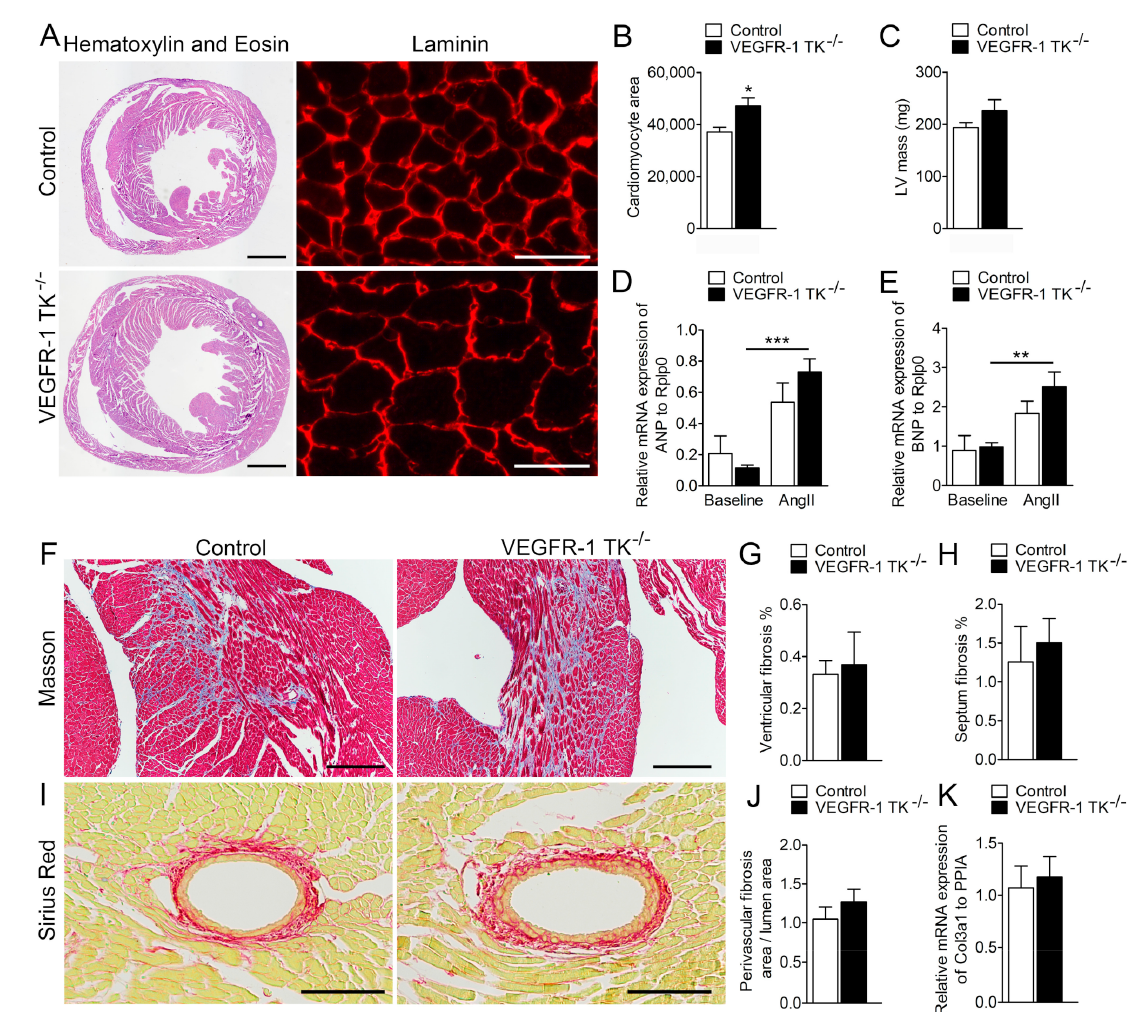
Figure 4. VEGFR-1 TK − / − mice display cardiomyocyte hypertrophy at day 14. ( A ) Haematoxylin & Eosin (scale bar is 1000 µ m) and laminin (scale bar is 25 µ m) stainings of the myocardium at day 14 of angII infusion. ( B ) Quantification of cardiomyocyte area (n = 8–10/group). ( C ) LV mass measured with echocardiogram (n = 7–11/group). ( D ) Relative ANP mRNA expression measured with RT qPCR (n = 5–7/group). ( E ) Relative BNP expression measured with RT qPCR (n = 5–7/group). ( F ) Masson’s staining of the myocardium (scale bar is 250 µ m). ( G ) Quantification of the level of fibrosis in the ventricles (n = 6–9/group). ( H ) Quantification of the level of septal fibrosis (n = 6–9/group). ( I ) Sirius Red staining of the perivascular fibrosis (scale bar is 100 µ m). ( J ) Quantification of the level of perivascular fibrosis (n = 6–9/group). ( K ) Relative mRNA expression of Col3a1 measured with RT qPCR (n = 5–7/group). Values are mean ± SEM. Statistical analyses were performed using one-way ANOVA with Bonferroni’s post hoc test and Student ´ s t -test. *** p < 0.001; ** p < 0.01; * p <